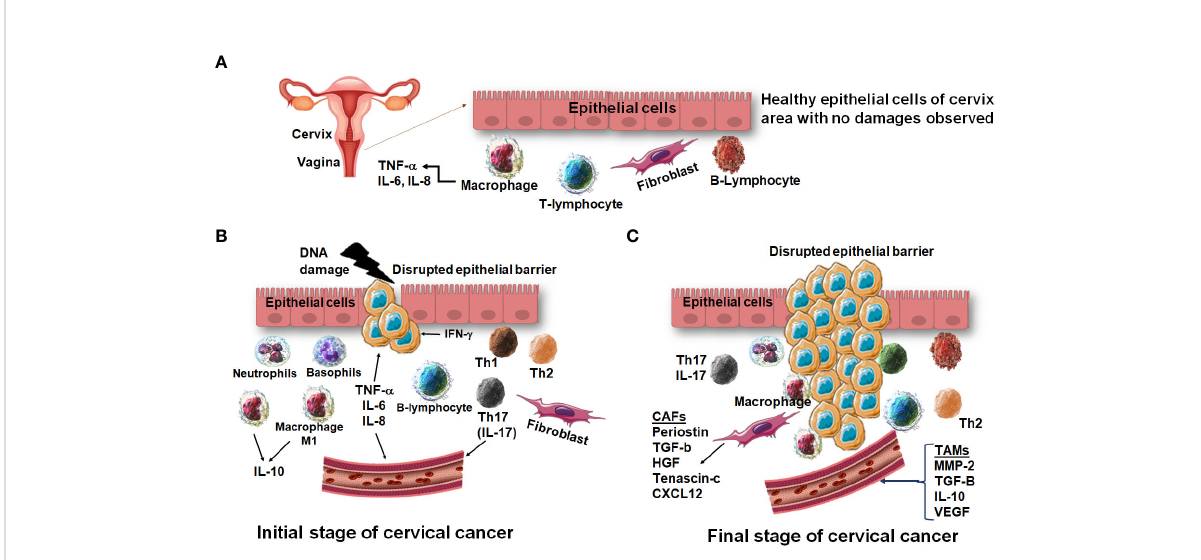
FIGURE 4 A comparative immunological pro fi le of cervical epithelium. (A) The normal epithelium shows a balanced expression of cytokines and chemokines. (B) The early induction of cervical cancer shows DNA damage followed by overexpression of pro-in fl ammatory cytokines and chemokines. (C) At the advanced stage of cervical cancer, the cervical epithelium is disrupted, and migration of cells is